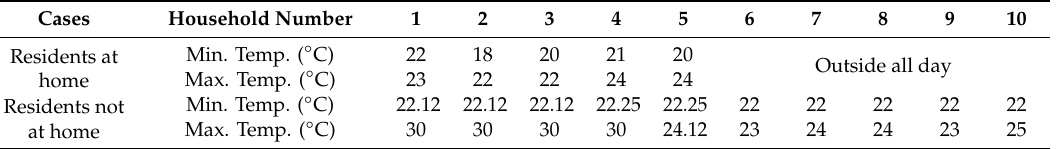
Table 7. Temperature control of each household in the building.